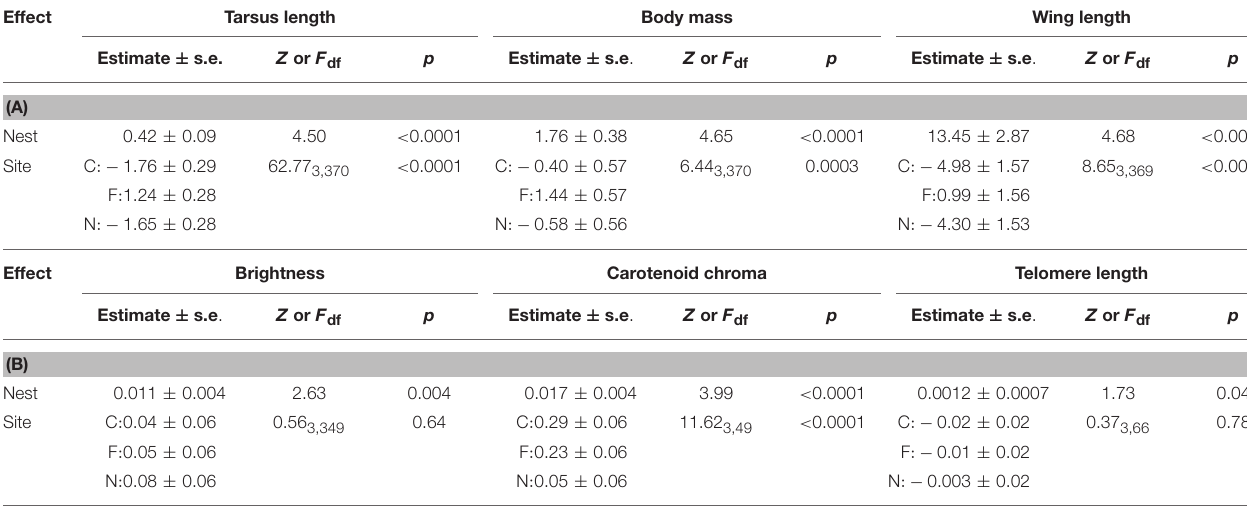
TABLE 2 | Mixed linear models investigating variation in great tit nestlings’ phenotype as a function of site and season. Effect Tarsus length Body mass Wing length Estimate ± s.e. Z or F df p Estimate ± s.e . Z or F df p Estimate ± s.e . Z or F df